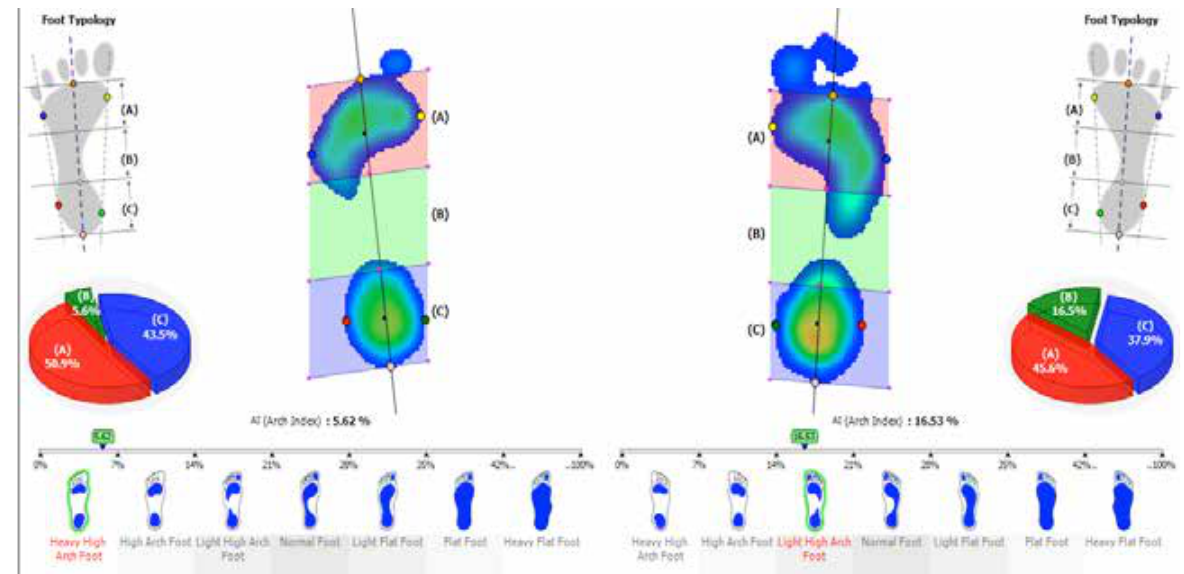
Fig. 2. Sample diagram with the results of the subject’s foot pressure distribution of the ground, from the Biomech Studio software